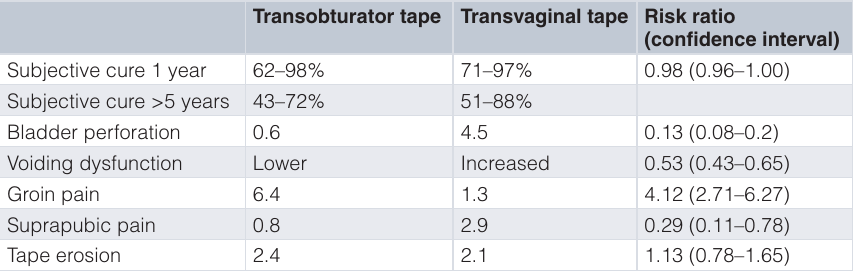
Table 4. Comparison of transobturator tape and transvaginal tape